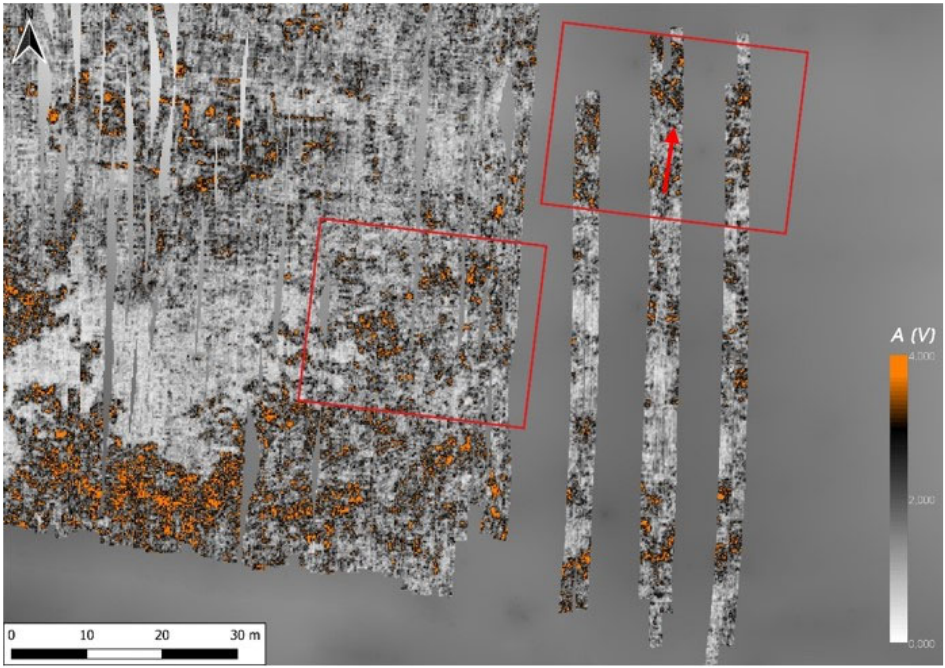
Figure 8. Detail of the east side (Area 3) at 0.5 m depth. Above, a small quadrangular anomaly. Below, the large rectangular structure with its compartmentalised zones. The red arrow indicates the area chosen for the radargram analysis (Figure 9).